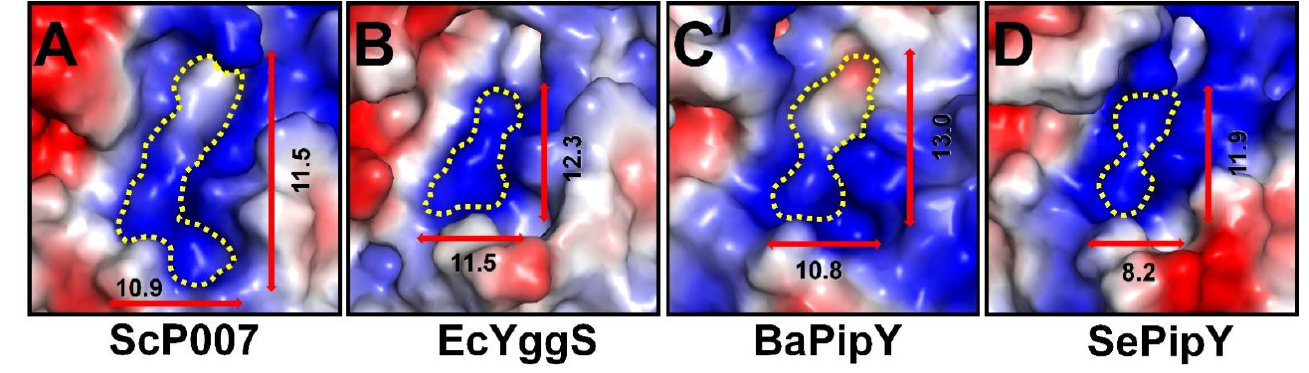
Figure 5. Electrostatic surface of the PLP-binding pocket of ( A ) ScP007 (PDB ID: 1B54), ( B ) EcYggS (1W8G), ( C ) BaPipY (3CPG), and ( D ) SePipY (5NM8).